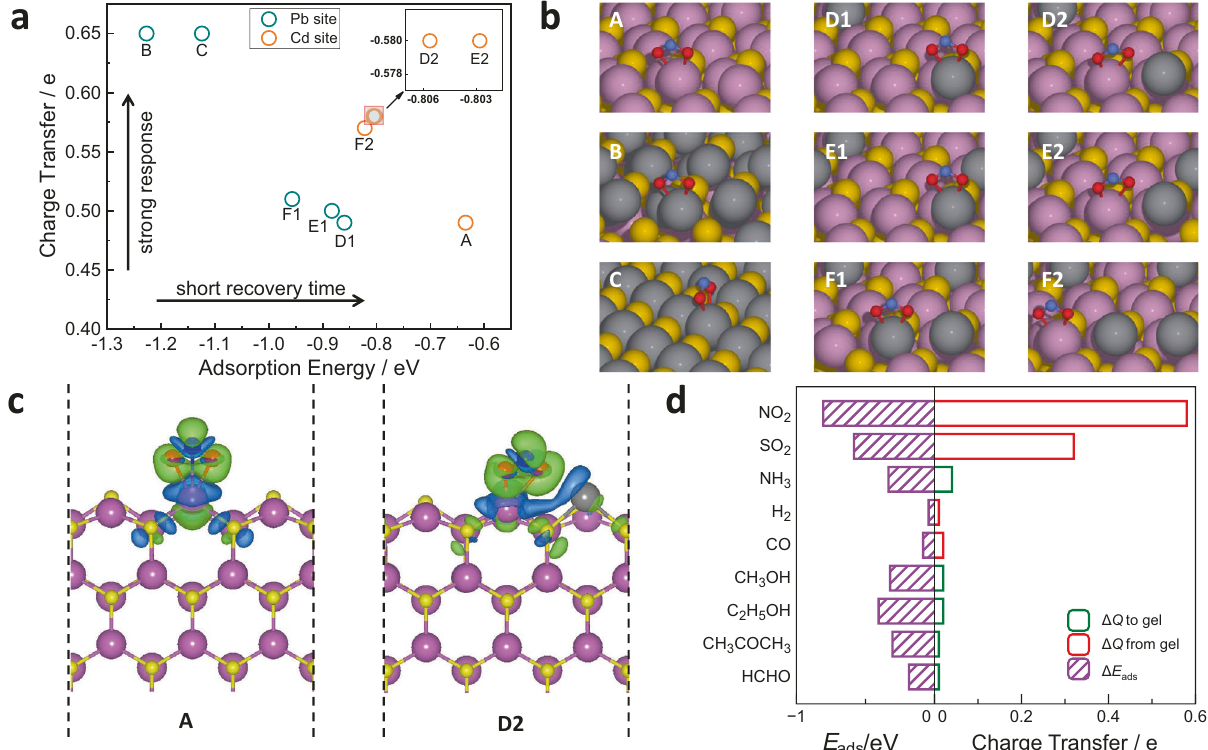
Fig. 5 DFT calculation results of NO 2 adsorption energies and the degrees of charge transfer to understand the sensing performances of the Pb x Cd 1 − x Se gel sensor. a Plot of charge transfer vs adsorption energy for NO 2 adsorption on various surface structures of Pb x Cd 1 − x Se: hexagonal CdSe (100) surface (A), a hexagonal CdSe (100) surface covered by a monolayer of PbSe (B), cubic PbSe (100) surface (C), and a hexagonal CdSe (100) surface with atomically dispersed Pb (D1, D2, E1, E2) or two neighboring Pb (F1, F2). b The corresponding NO 2 adsorption geometries. Pb, Cd, Se, N, and O atoms are shown as gray, purple, yellow, blue, and red balls, respectively; their top and side view fi gures are provided in Supplementary Fig. 27. c Calculated differential valence-electron charge densities of NO 2 adsorption for A and D2 in panel b ( 4 ρ ¼ ρ illustrated by blue and green, respectively. d Calculated adsorption energies (left side) and charge transfer (right side) for different gases on the D2 surface in panel b . The charge transferred from and to the surface is plotted in red and green,